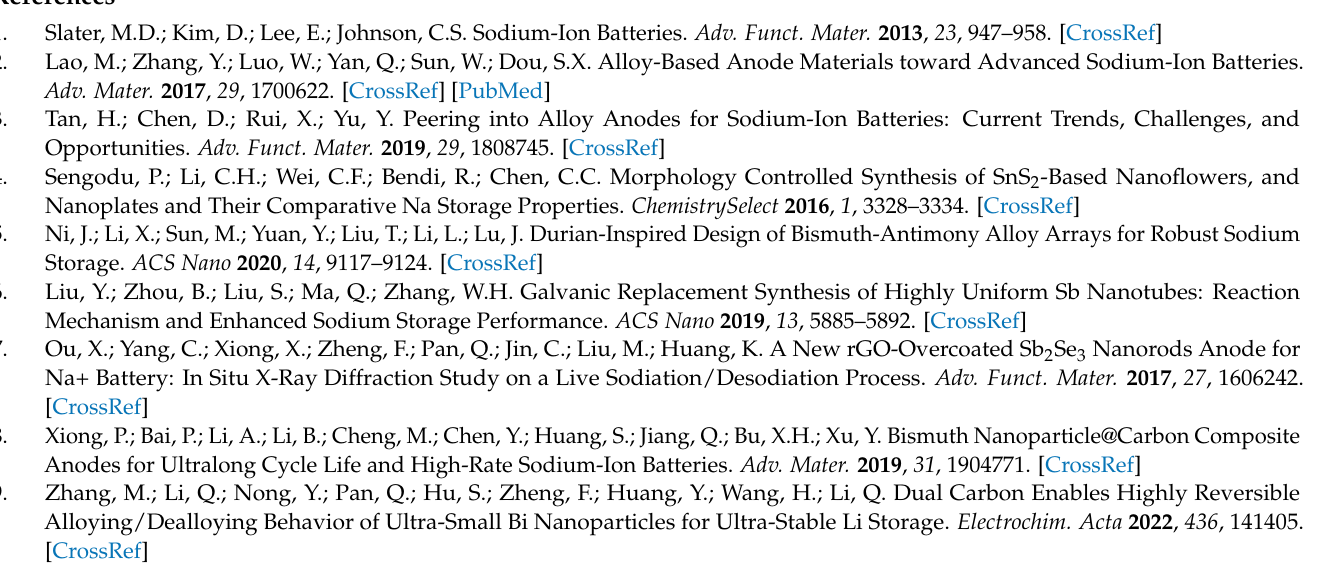
Figure S3: The corresponding EDX results of the (a)Bi@C, (b) Sb@C, (c) Bi 3 Sb 1 @C, (d) Bi 1 Sb 1 @C, (e) Bi 2 Sb 3 @C, and (f) Bi 1 Sb 3 @C samples; Figure S4: The size distribution pattern of the Bi 1 Sb 1 alloy for the Bi 1 Sb 1 @C sample; Figure S5: The low-resolution XPS spectrum of the Bi 1 Sb 1 @C sample; Figure S6: N 2 adsorption-desorption isotherms of the (a) Bi@C, (b) Bi 3 Sb 1 @C, (c) Bi 2 Sb 3 @C, (d) Bi 1 Sb 3 @C, and (e) Sb@C samples; Figure S7: The pore size distribution curves of the (a) Bi@C, (b) Bi 3 Sb 1 @C, (c) Bi 2 Sb 3 @C, (d) Bi 1 Sb 3 @C, and (e) Sb@C samples; Figure S8: Initial three cycles of CV curves at a scan rate of 0.1 mV s − 1 of the (a) Bi 2 Sb 3 @C and (b) Bi 1 Sb 3 @C samples; Figure S9: The discharge-charge curves of the (a) Bi 3 Sb 1 @C, (b) Bi 2 Sb 3 @C, and (c) Bi 1 Sb 3 @C samples during the initial three cycles; Figure S10: The discharge-charge profiles at different current densities of the (a) Bi@C, (b) Bi 3 Sb 1 @C, (c) Bi 2 Sb 3 @C, (d) Bi 1 Sb 3 @C, and (e) Sb@C samples; Figure S11: Nyquist plots of (a) Bi 1 Sb 1 @C and (b) Sb@C before/after the first cycle. (c, d) Fitted circuit diagram and corresponding fitting results; Figure S12: The GITT curves of the (a) Bi@C, (b) Bi 3 Sb 1 @C, (c) Bi 2 Sb 3 @C, (d) Bi 1 Sb 3 @C, and (e) Sb@C samples during the first discharge and charge processes; Figure S13: Schematic of one discharge pulse at ~0.75 V (vs. Na + /Na) for the Bi 1 Sb 1 @C electrode during discharge process; Figure S14: The diffusion rate for Na+ of the (a) Bi@C, (b) Bi 3 Sb 1 @C, (c) Bi 2 Sb 3 @C, (d) Bi 1 Sb 3 @C, and (e) Sb@C samples during the first discharge and charge